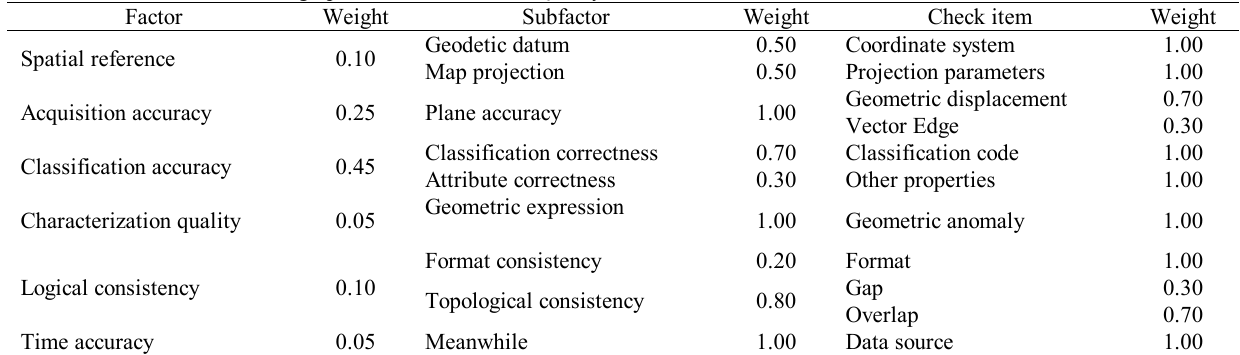
Table 1. Quality factors and weight set of land cover classification